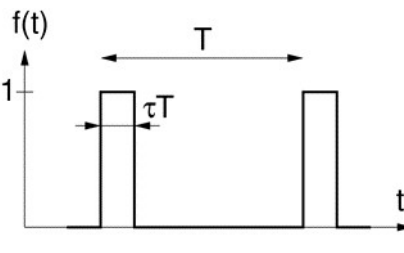
Figure 25. Reduced duty cycle actuation.